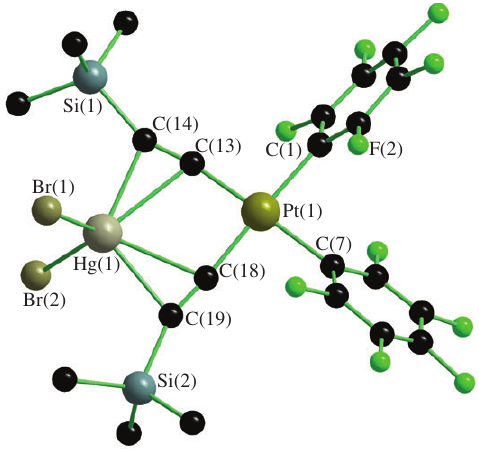
Figure 8 Structure of [Pt (C al., 1994).